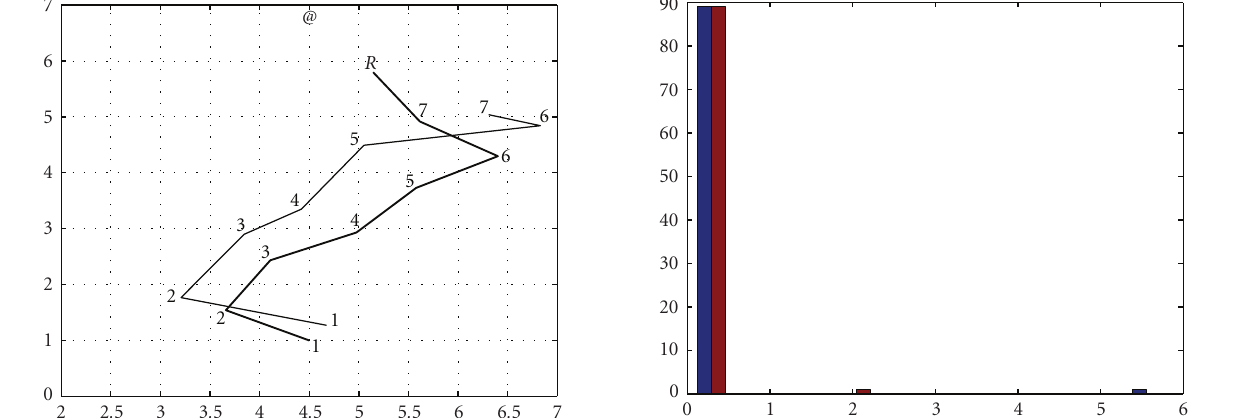
Figure 4: Histogram of position di ff erences of 350 steps in both x and y directions shows that the trajectories generated from two algorithms are the